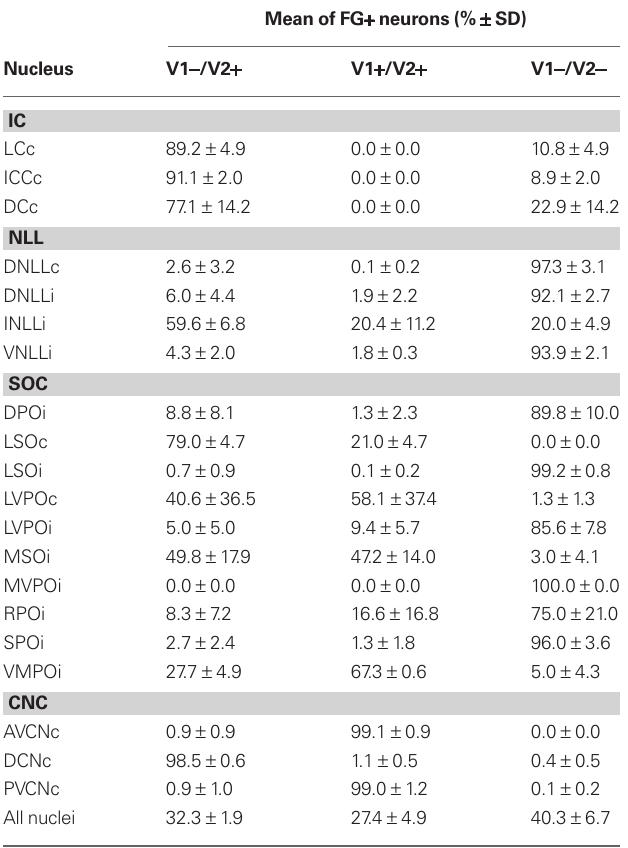
Table 2 | Mean percentage and standard deviation of all Fg-positive cells that express VgLuT1 (V1) and VgLuT2 (V2) calculated from the three cases in Table 1.